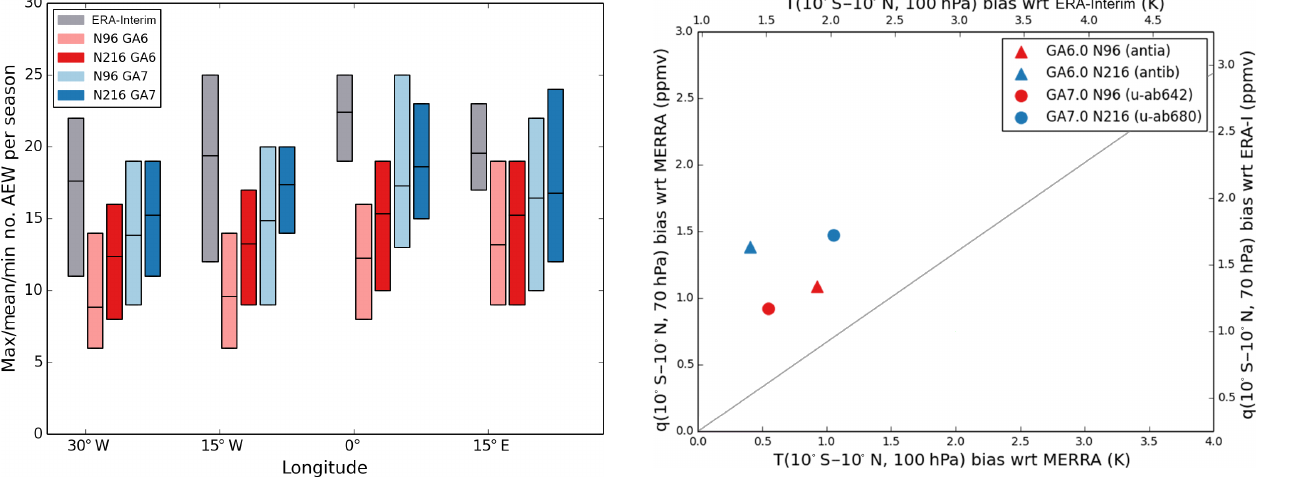
Figure 20. Tropical tropopause layer temperature biases and lower stratospheric humidity biases from 27-year N96 and N216 atmosphere/land-only climate simulations of GA6.0 and GA7.0 versus MERRA and ERA-Interim reanalyses (following Hardiman et al., 2015). Table 8. Mean value of the global energy correction applied over the 27-year simulations at N96 and N216 presented